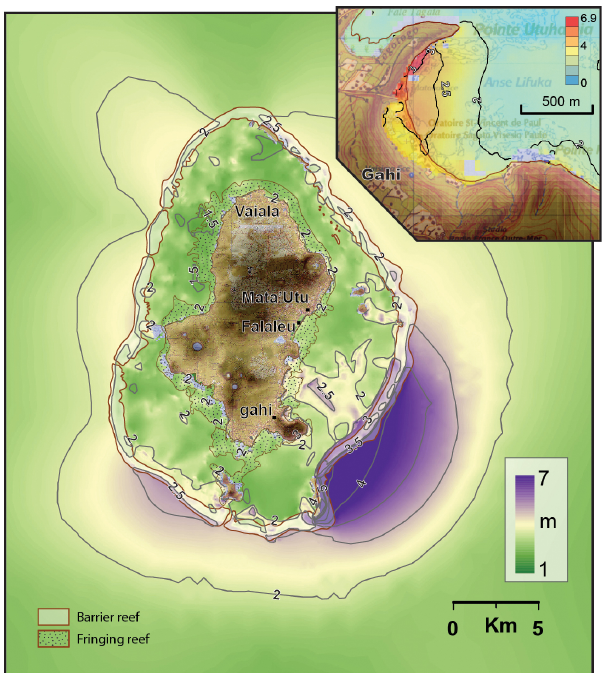
Figure 16. Synthesis of all maximum wave elevation models (in m) at Wallis for the 15 scenarios generated for this study. Insert: inundation map in Gahi, SE Uvéa.